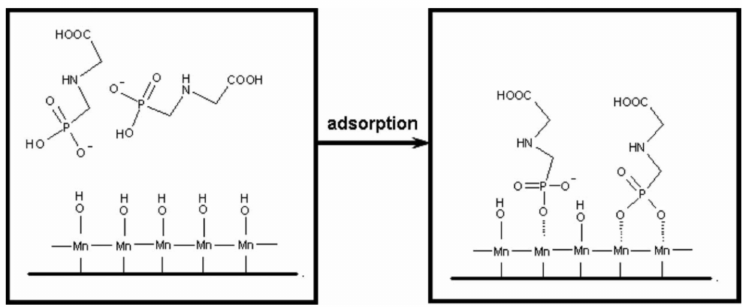
Figure 4. Kinetic of chemical adsorption on porous material